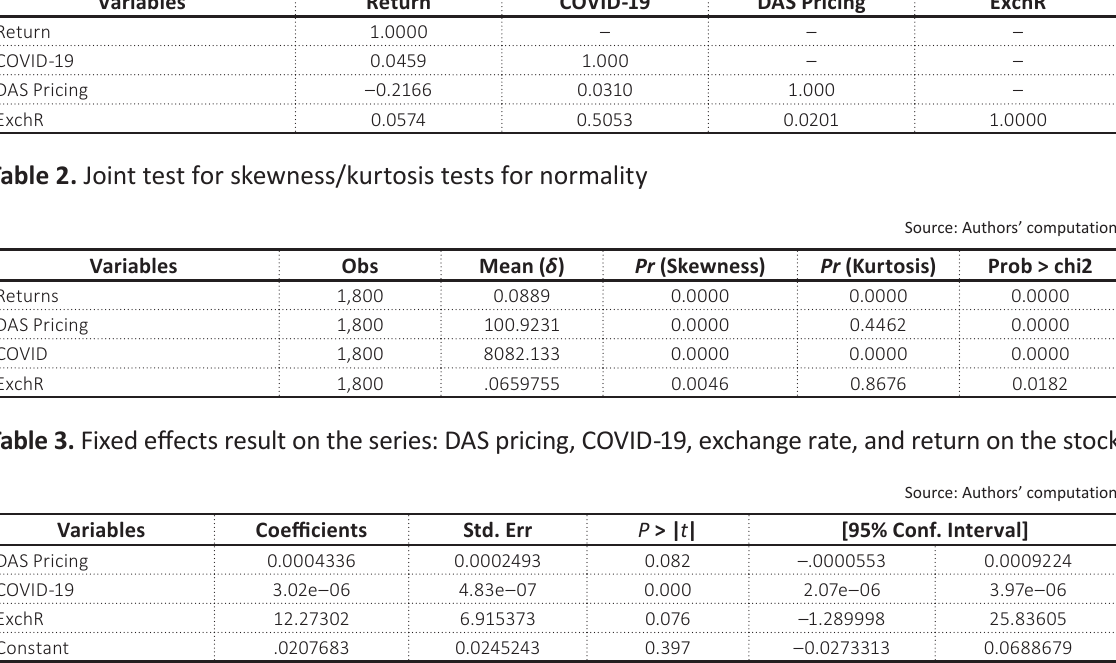
Table 1. Panel correlation matrix for all the twenty firms under investigation